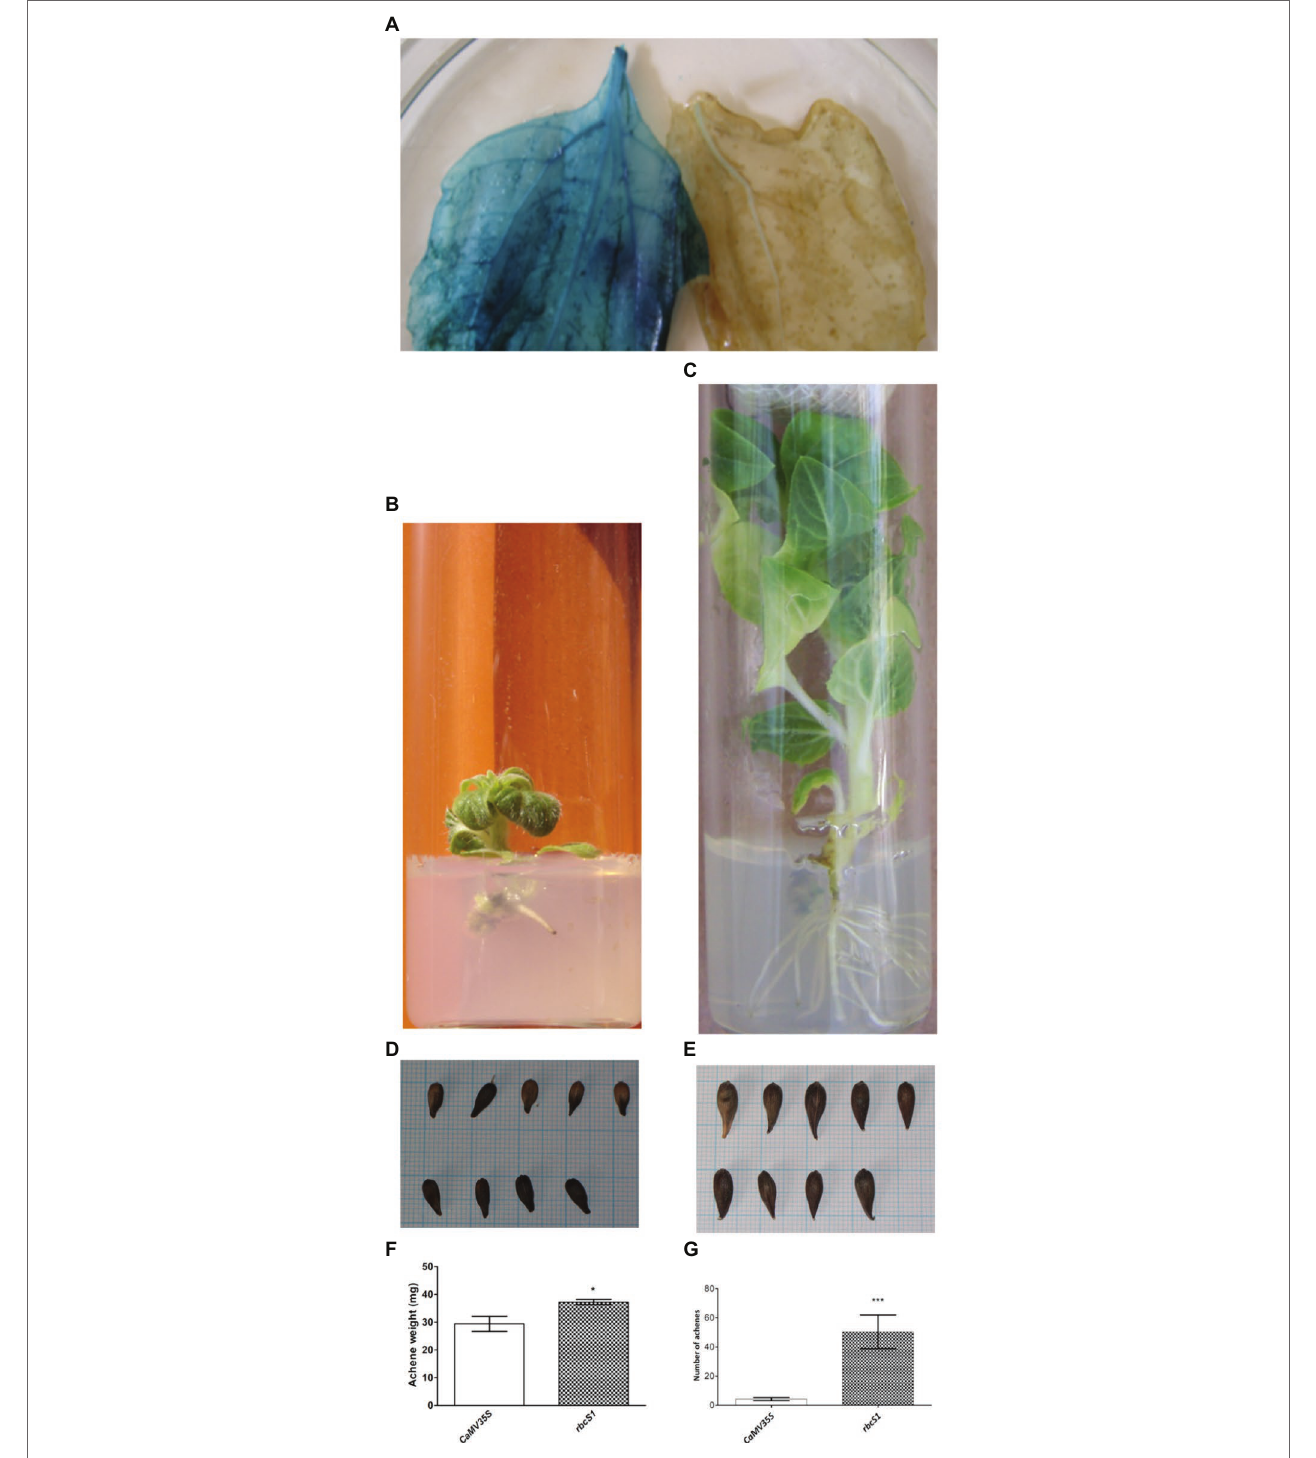
FIGURE 1 | Comparison of transgenic sunflowers carrying constructions with either CaMV35S or rbcS1 promoters. GUS histochemical staining of leaves from rbcS1 promoter- GUS gene transgenic (left) and control (right) sunflower plants (A) . In vitro root development in kanamycin with constructions carrying either CaMV35S (B) or rbcS1 (C) promoters. Sizes of achenes from transgenic sunflowers carrying constructions with either CaMV35S (D) or rbcS1 (E) promoters. Weight of achenes in mg * p < 0.01 ( t -test) (F) and number of achenes per floral chapter *** p < 0.001 (Welch’s t -test) (G) from transgenic sunflowers carrying constructions with either CaMV35S or rbcS1 promoters. Source: Radonic